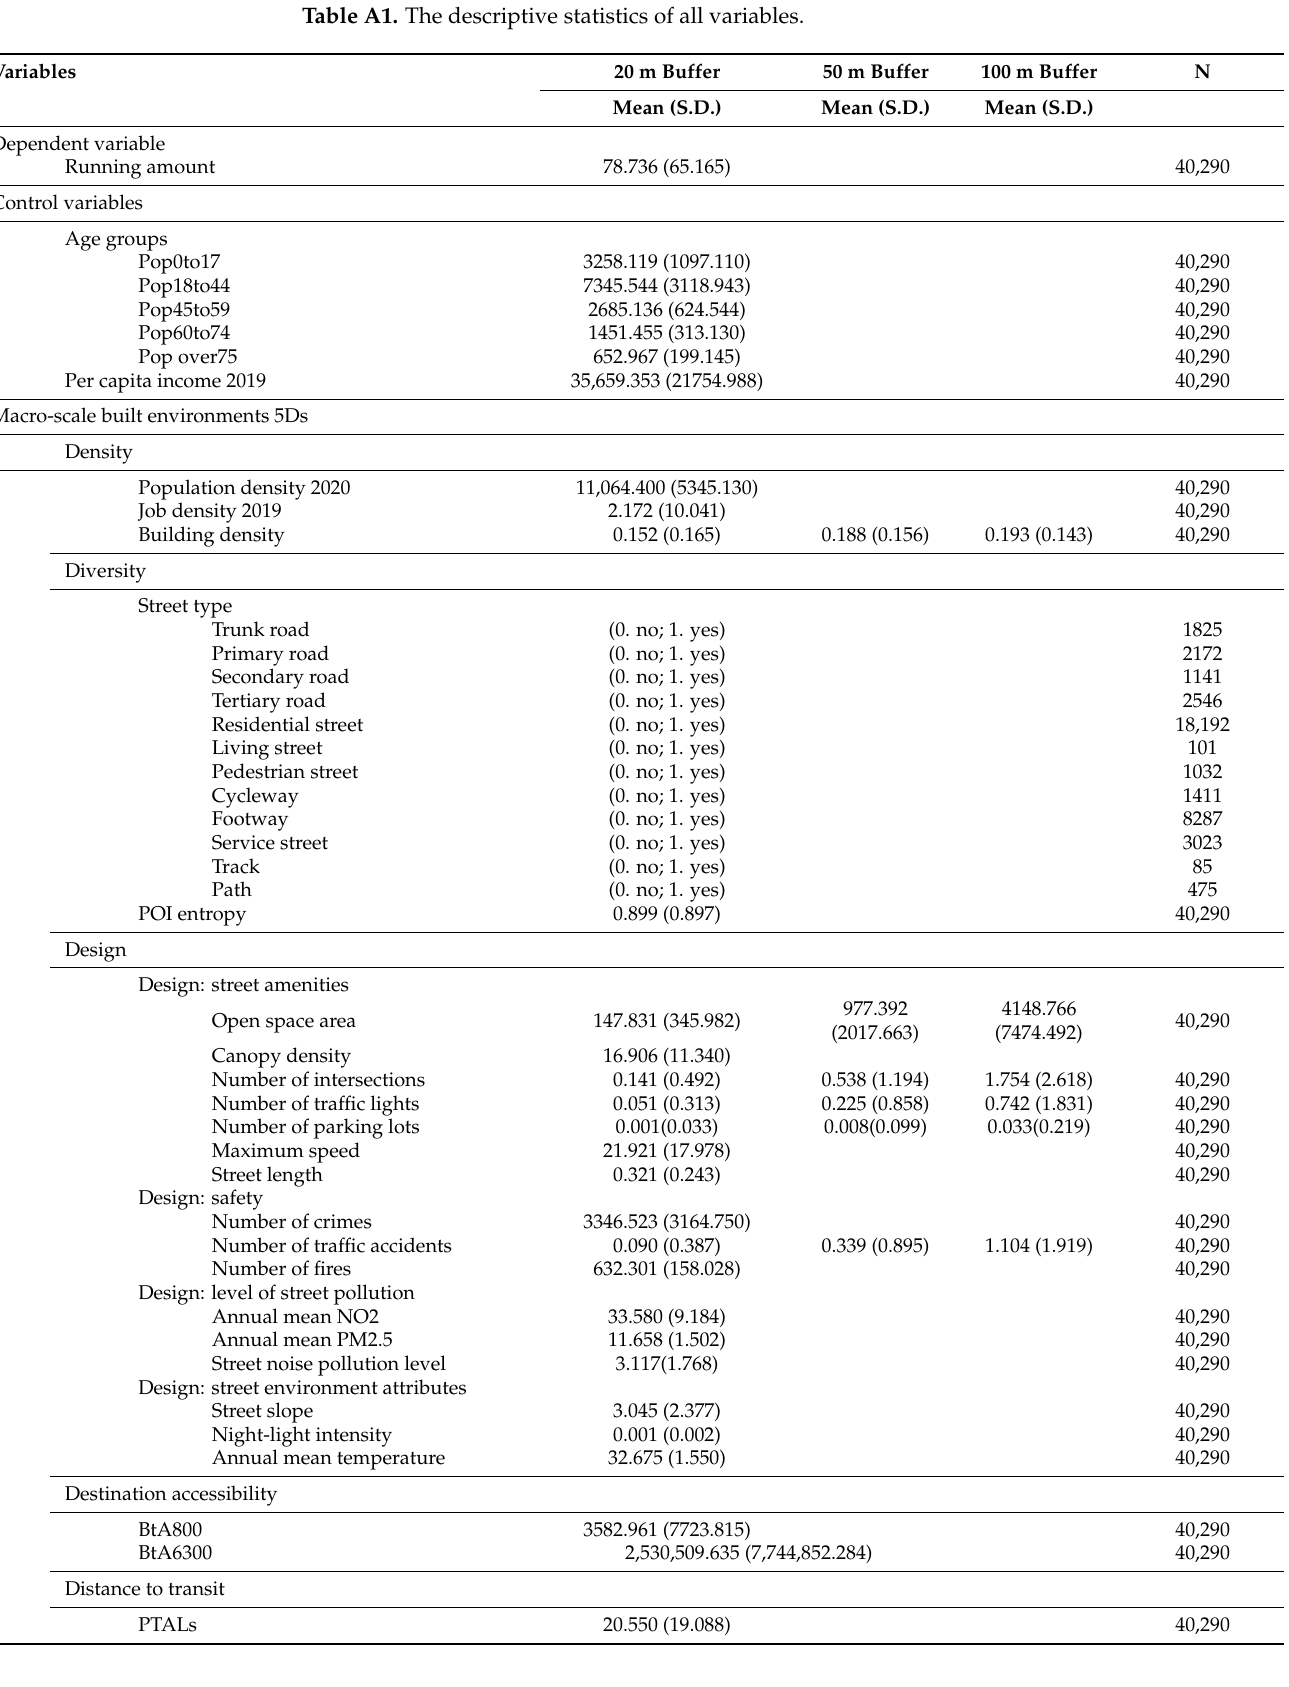
Table A1. The descriptive statistics of all